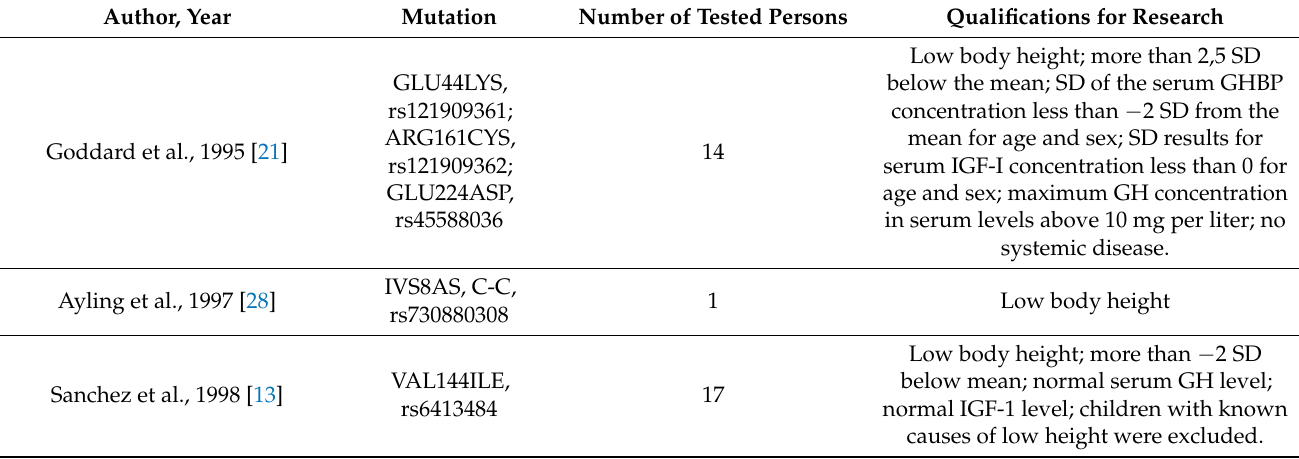
Table 1. List of publications that describe mutations in the GHR and the IGF1R genes, along with the number of people tested in these studies, the discovered mutations, and a description of the qualification criteria for the